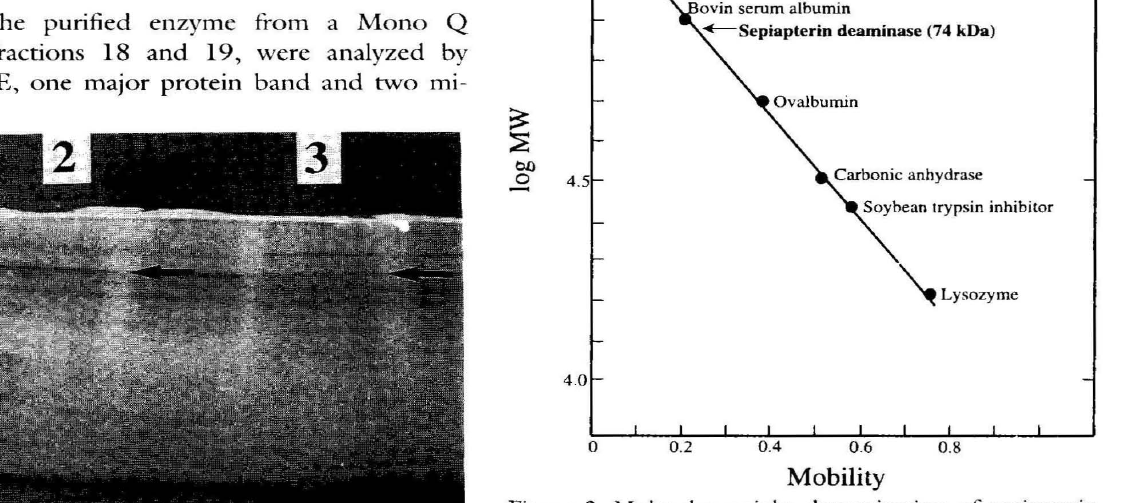
Figure 2. SOS-PAGE of the final purification step of sepiapterin deaminase from the integument of the lemon mutant larvae of the silkworm. Lane 1 contains molec ular weight marker proteins. Lane 2 and 3 show the pro teins in fractions 18 and 19 from a Mono Q column, respectively. The arrows show sepiapterin deaminase. Pteridines/ VoL 9 / No. 1